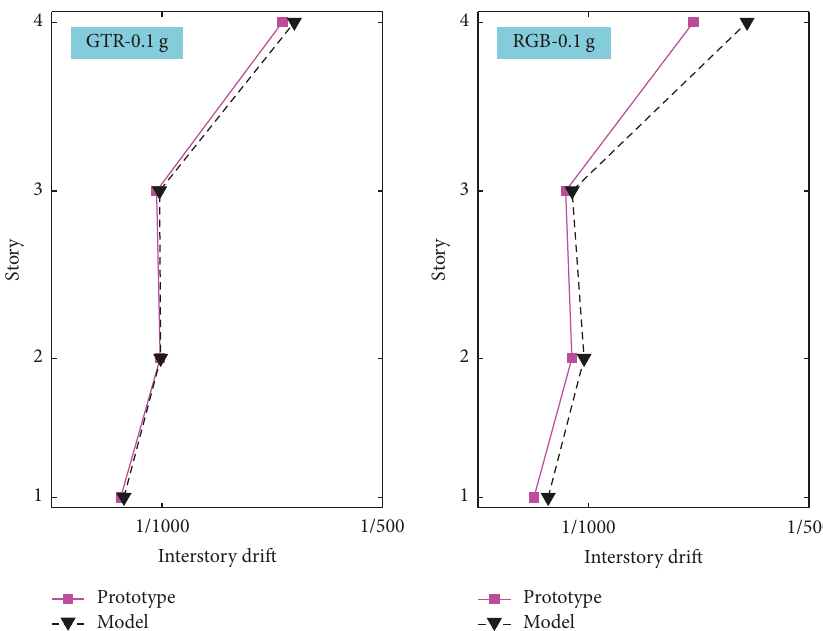
Figure 18: Interstory drift of the prototype structure and test model structure under frequent earthquakes.